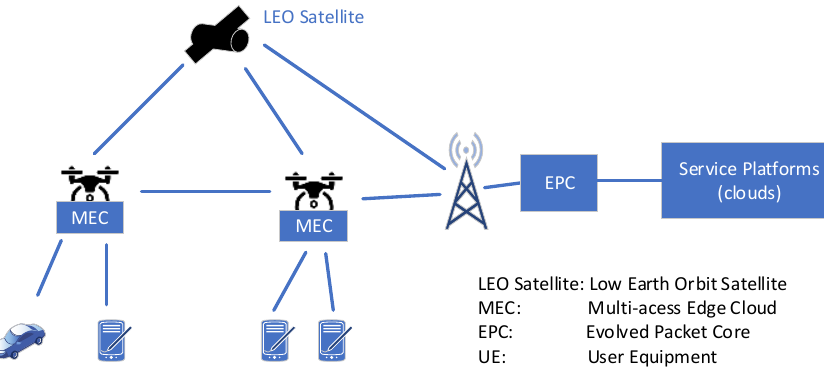
Figure 3. MEC-enabled UAVs combined with NTN (an